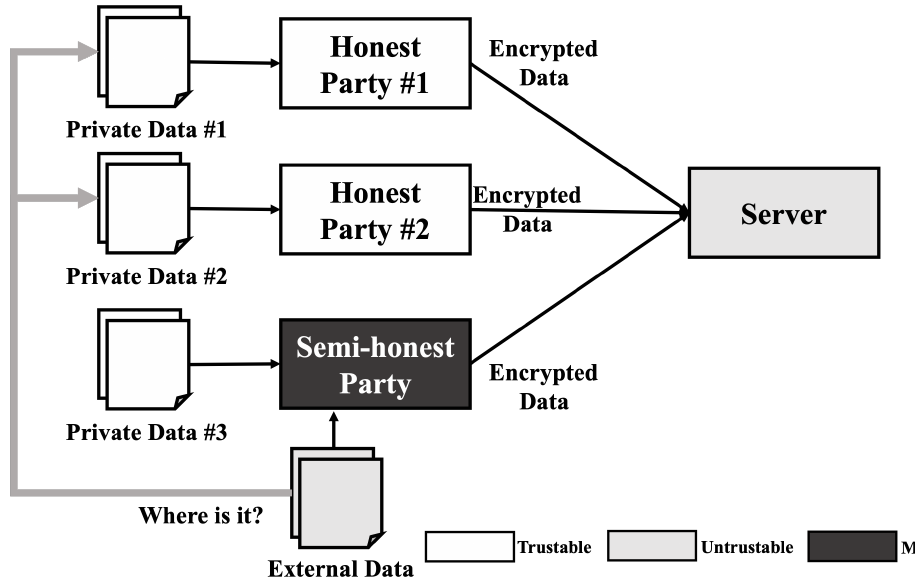
Figure 3. Membership inference attack scenario on HE-based deep learning